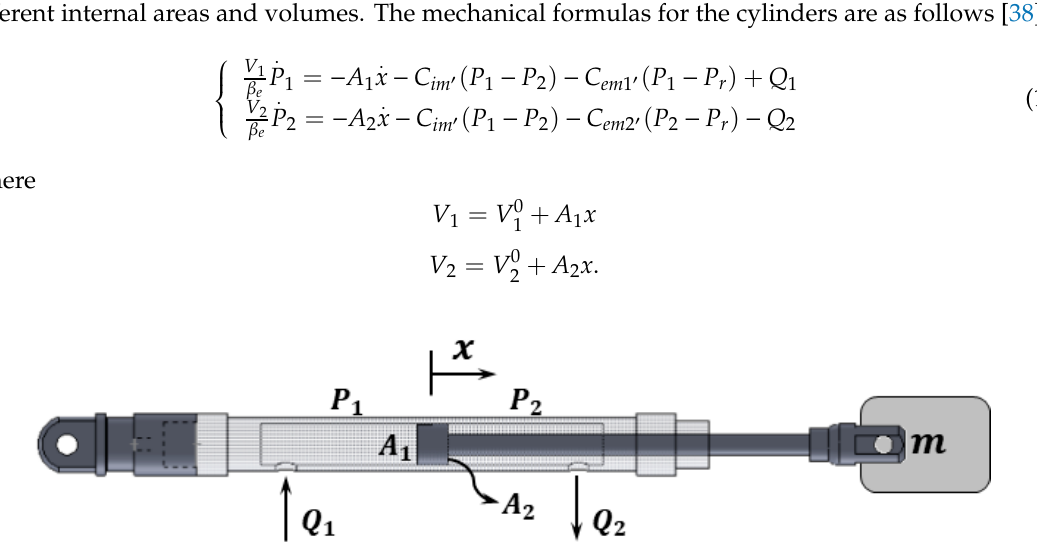
Figure 8. Sliding mode control scheme.